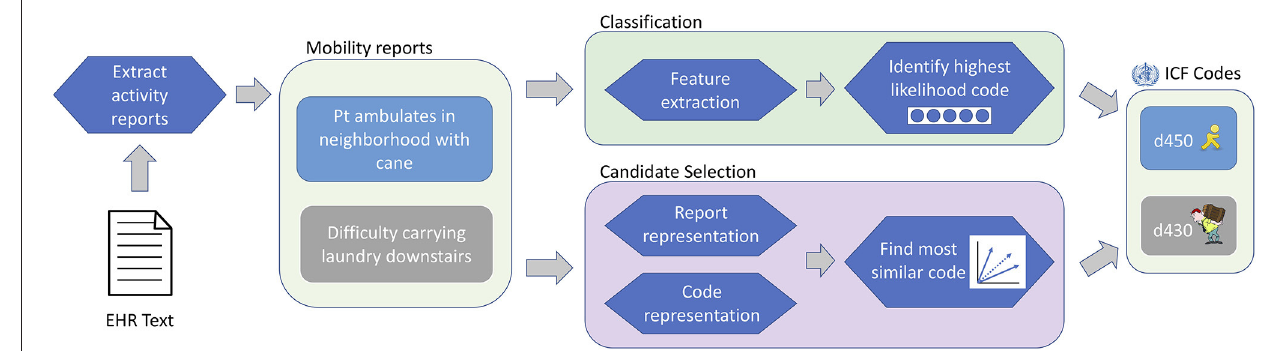
FIGURE 3 | ICF coding workflow. EHR texts are analyzed to identify activity reports (provided a priori for this study), which are assigned ICF codes under either the classification or candidate selection